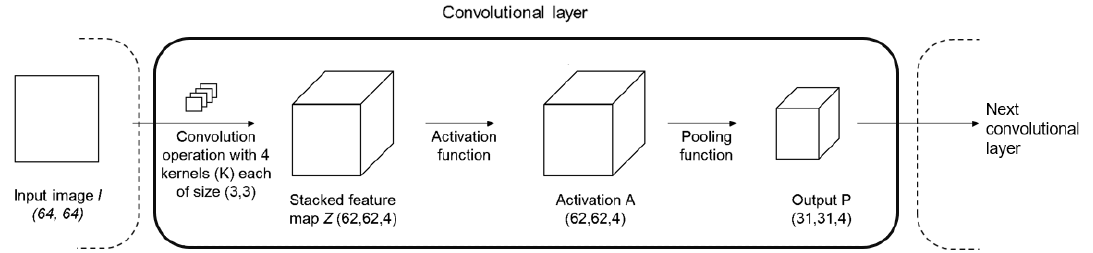
Figure 1. Typical convolutional layer comprising of convolution, activation, and pooling operations. Convolutional layers progressively extract higher dimensional image representations ( P l —output P at layer l ). With enough layers and training, a deep convolutional network can yield robust features that help perform the cognitive task. The aim of training is to arrive at the optimized set of values, referred to as parameters, within the kernels K l (kernel K at layer l ). These parameters can successfully transform the original CT slice/volume ( I ), with values in Hounsfield units (HUs) into the regions-of-interest, i.e., segmentation masks